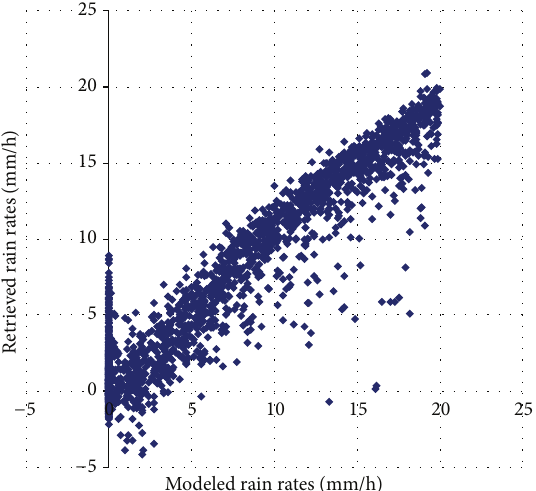
Figure 2: Scatterplot of retrieved rain rate values versus modeled rain rates for testing dataset. Figure 3: Field of Δ𝑇 𝐵 H 10,7 ; difference in AMSR2 measurements at